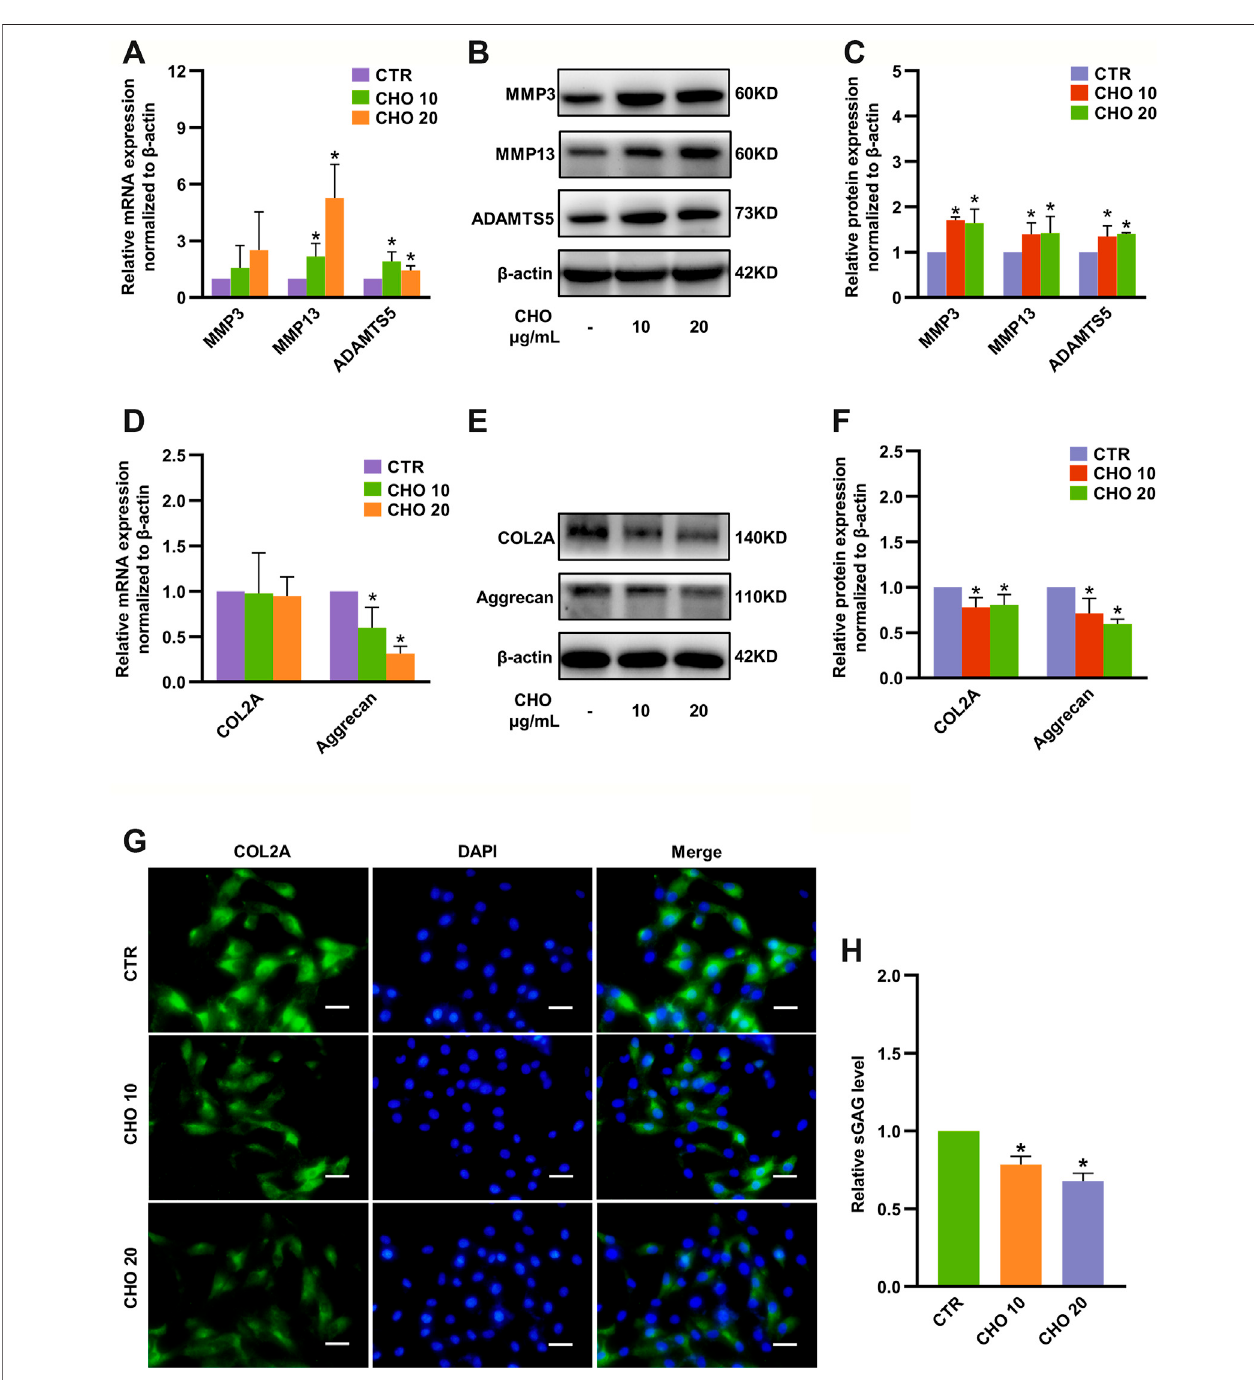
FIGURE 2| Cholesterolaccelerates matrix catabolism and diminishesmatrix anabolism in rat NP cells. (A) RT-qPCR analysisof MMP3, MMP13 and ADAMTS5 in NP cells treated with 10 and 20 μ g/ml cholesterol (n (cid:1) 3 – 5). (B, C) Western blot analysis and quanti fi cation showing that protein expressions of MMP3, MMP13 and ADAMTS5 were markedly upregulated by cholesterol stimulation (n (cid:1) 3). (D) mRNA levels of COL2A and aggrecan in NP cells treated with cholesterol (n (cid:1) 3 – 4). (E, F) WesternblotsshowingtheproteinlevelsofCOL2AandaggrecaninNPcellsstimulatedwith10and20 μ g/mlcholesterolandthesubsequentquanti fi cation(n (cid:1) 3). (G) Representative images showing immuno fl uorescence staining of COL2A in NP cells after different cholesterol treatments (bar (cid:1) 50 μ m). (H) The concentrations of sGAG were decreased in the culture media after cells were stimulated with different concentrations of cholesterol for 72 h (n (cid:1) 4). The data are presented as the mean ± SD. * p < 0.05. CHO, cholesterol.